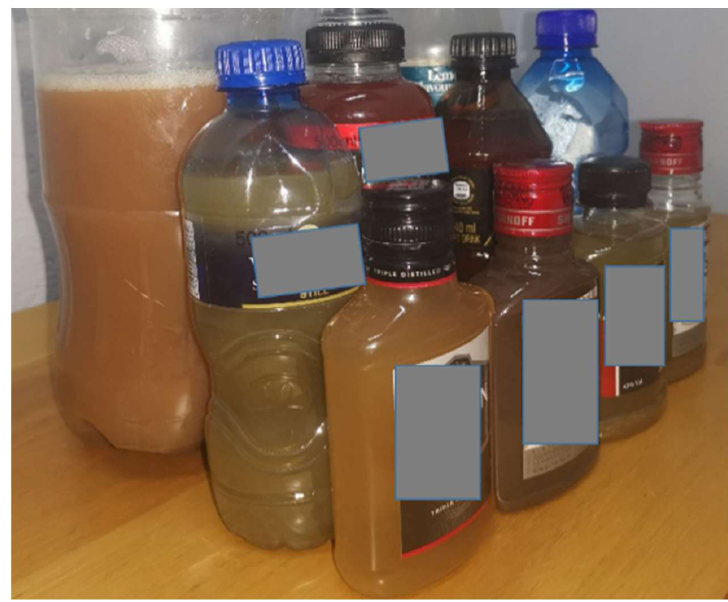
Figure 1. Samples of the aphrodisiac